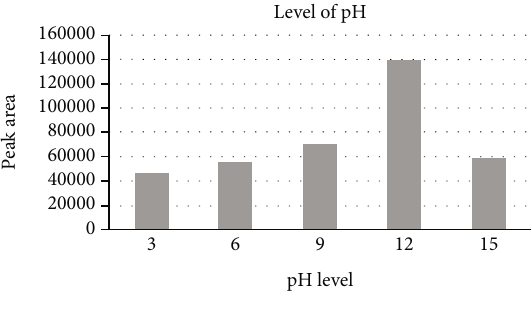
Figure 8: Graph of pH level.